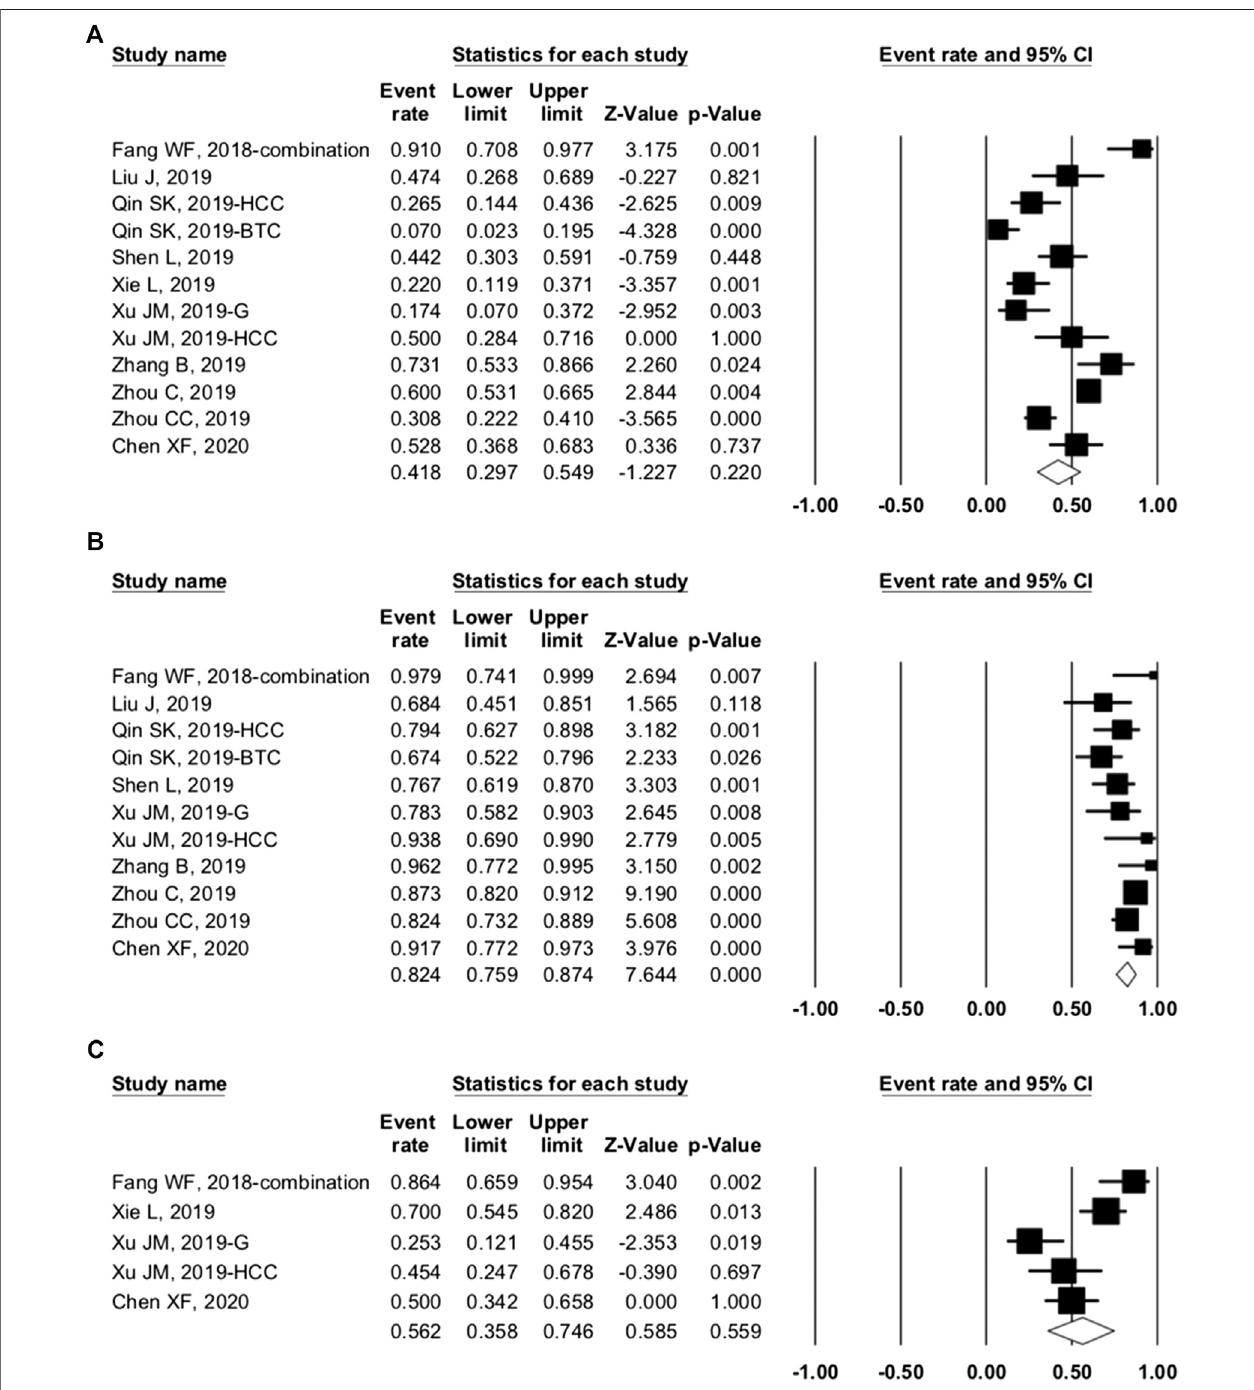
FIGURE 5 | Ef fi cacy ofcombination therapy. (A) overall response rate; (B) disease control rate; and (C) 6-month progression-free survival rate of included studies.